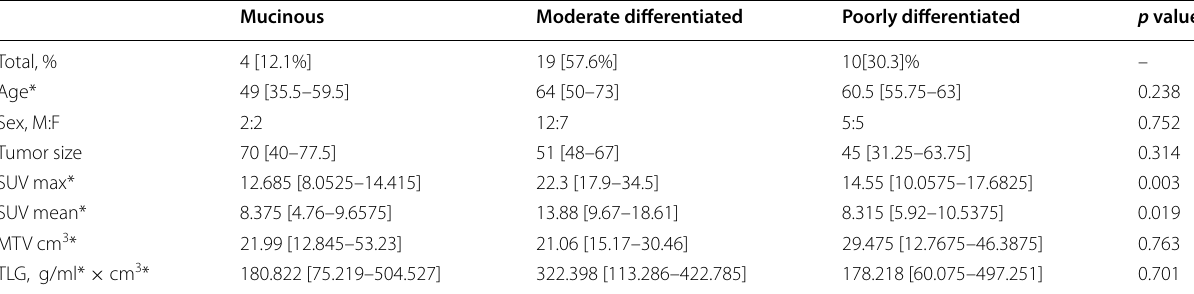
Table 2 Demographic and PET/CT characteristics according to the different histopathological groups